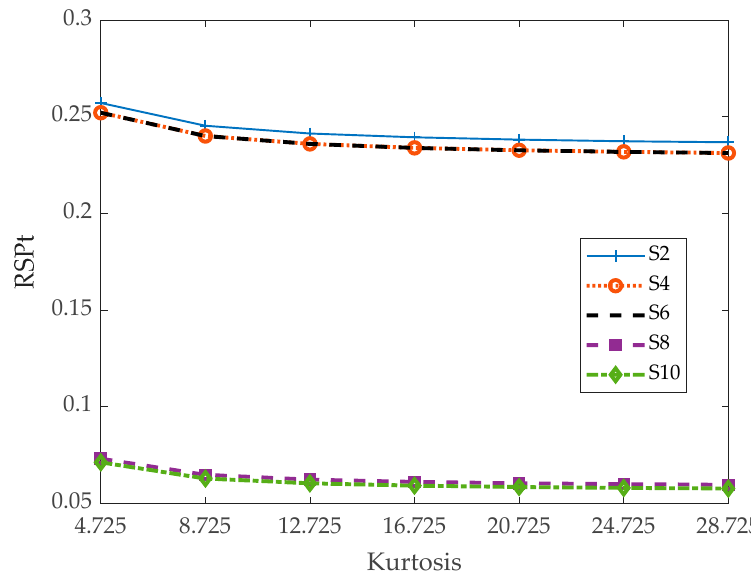
Figure 10. RSP t results for kurtosis-varying scenarios, i.e., S2, S4, S6, S8, and S10. The ratio of the skewness increment, i.e., 0.2 (the kurtosis increment, i.e., 4), to the skewness (kurtosis) of the base case is approximately 28% (85%). The ratio for skewness is smaller than that for kurtosis; however, the effect of skewness is greater than that of kurtosis. It can be compared with the relative RSP t ratio, defined as the RSP t divided by the ratio calculated above. The largest relative RSP t for the skewness-varying (kurtosis-varying) scenario is 4.19% (1.41%); for reference, the largest changes in RSP t in the skewness-varying and kurtosis-varying scenarios are between 4.725 and 8.725 and 1.315 and 1.515 in S5 and S6, respectively. The average value of the relative RSP t for the skewness-varying (kurtosis-varying) scenarios for the entire interval was 1.72% (0.41%). In the kurtosis- varying scenarios, the RSP t in S2, S4, S6, S8, and S10 decreases with an increase in kurtosis. In the skewness-varying scenarios, the RSP t in S7 and S9 increases with an increase in skewness, whereas those in S1, S3, and S5 decrease. If the PDF is skewed to the left (i.e., the increase in skewness), it indicates that the load unexpectedly decreases. The